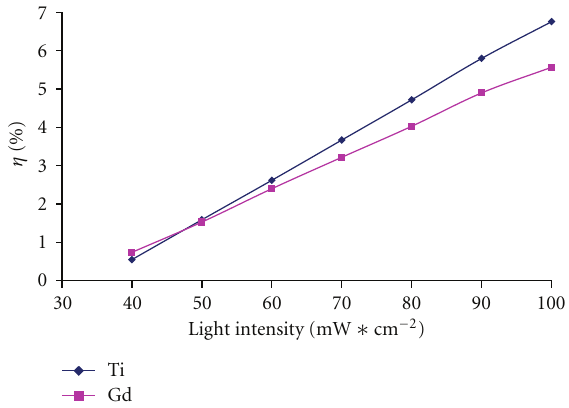
Figure 6: The relation between illumination intensity and overall photon-to-current e ffi ciency of Ti and Gd